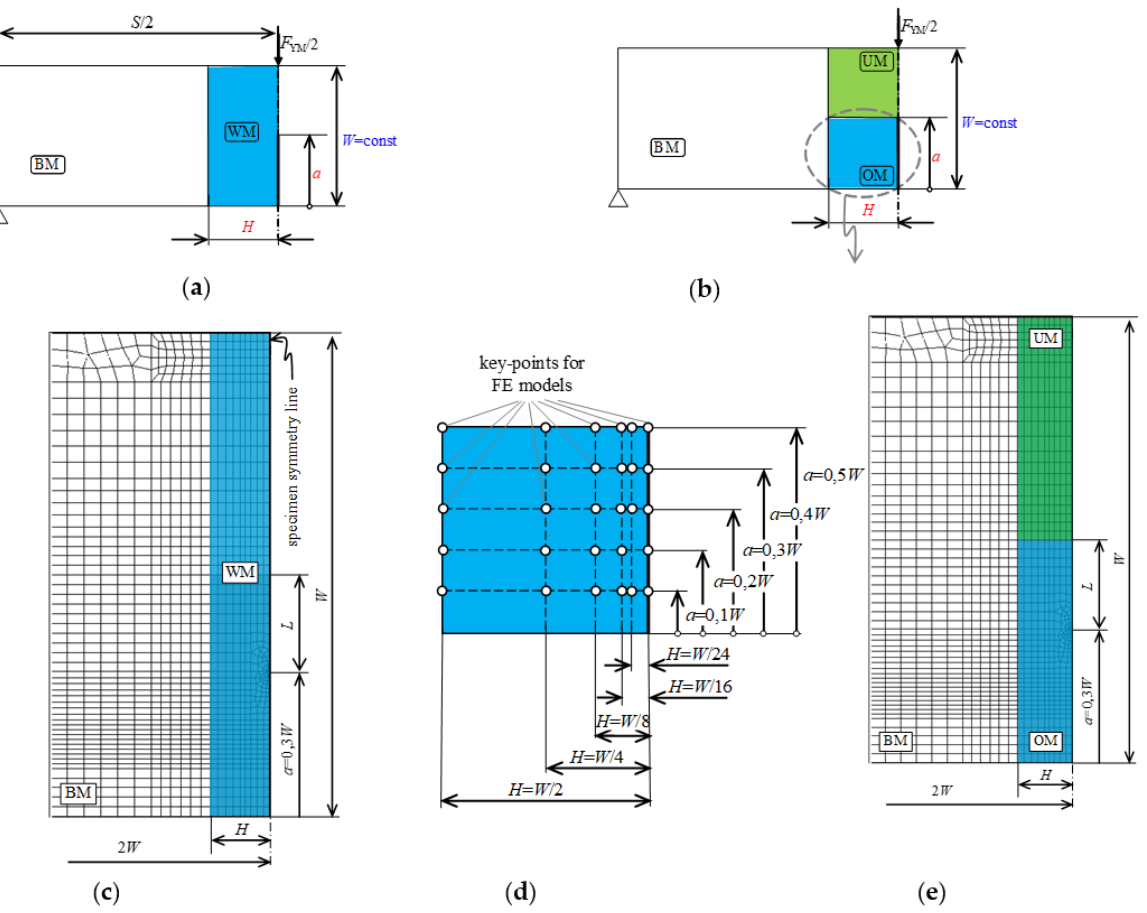
Figure 2. Numerical model: ( a ) homogeneous weld for verification; ( b ) heterogeneous weld; ( c ) detail of finite element mesh of homogeneous weld for verification; ( d ) key-points for variation of weld width H and crack length a ; ( e ) detail of finite element mesh of model with heterogeneous